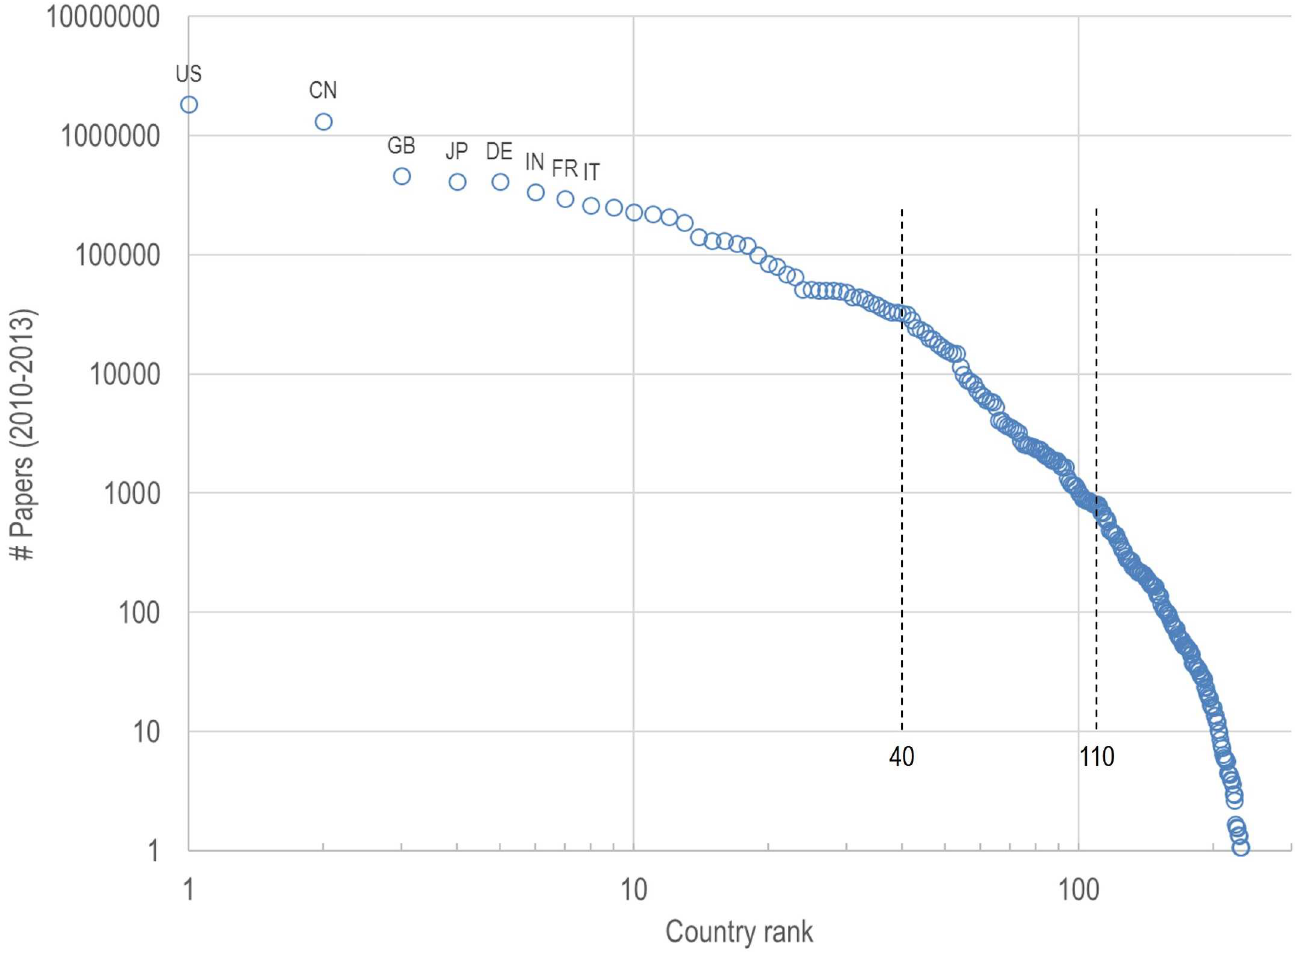
Fig 4. Distribution of national publication counts.